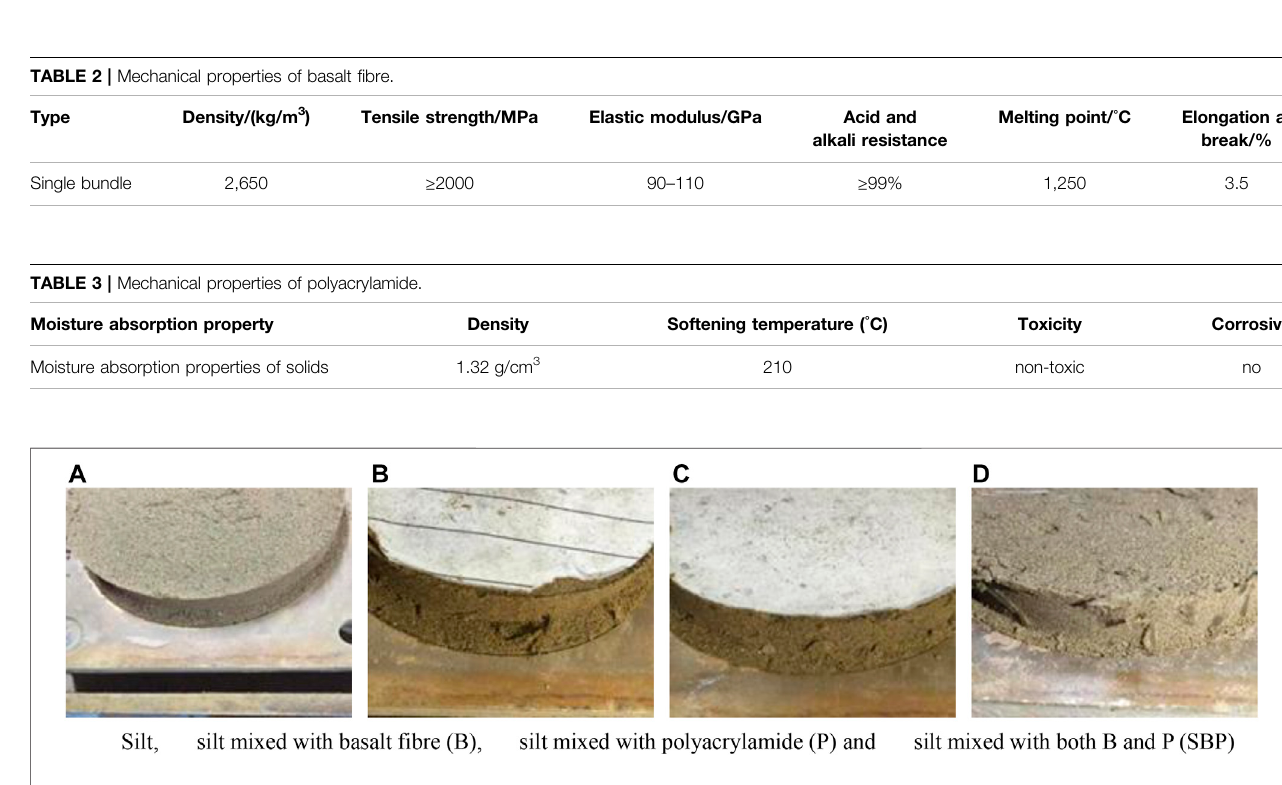
FIGURE2| Failuresurfacesofcompositespecimensinthedirectsheartest. (A) Silt, (B) siltmixedwithbasalt fi bre(B), (C) siltmixedwithpolyacrylamide(P)and (D) silt mixed with both B and P (SBP)